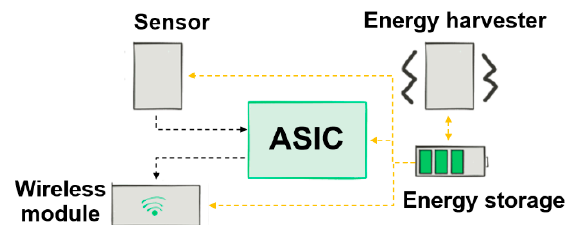
Figure 1. Example of an autonomous wireless sensor node composed of the sensor proper, the wireless module, an Application-Specific Integrated Circuit (ASIC) and an energy supply system.